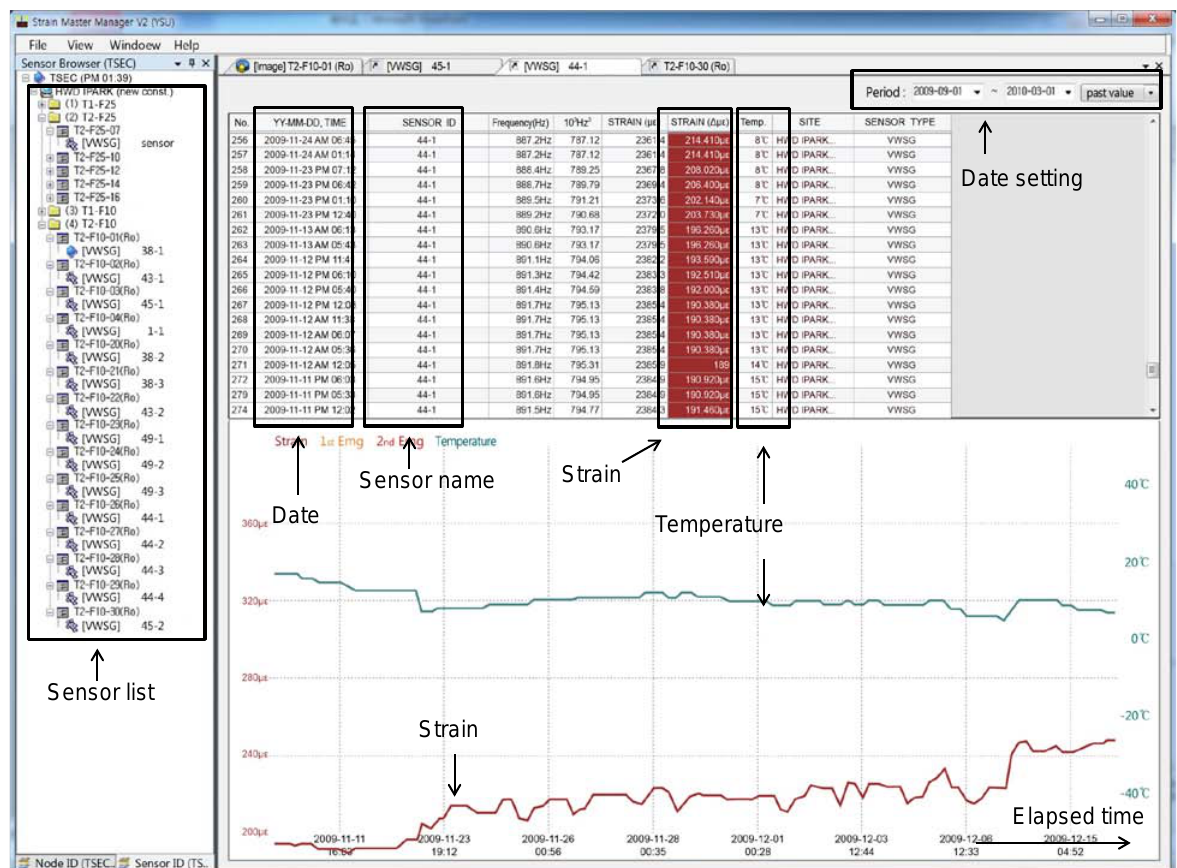
Figure 9. Screen capture showing measured data stored on the server through web-based managing